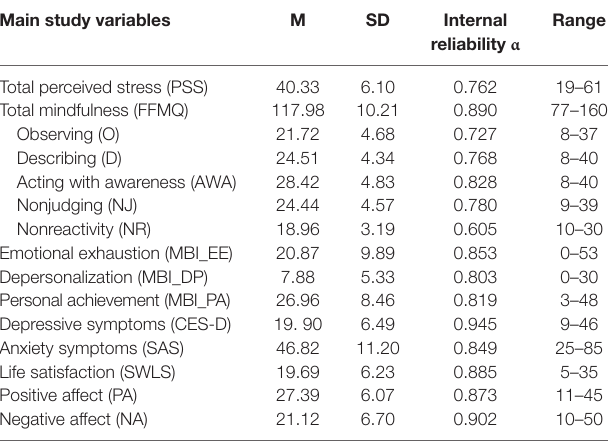
TABLE 2 | Descriptive statistics and psychometric properties of the major study variables ( n = 500). Main study variables M SD Internal